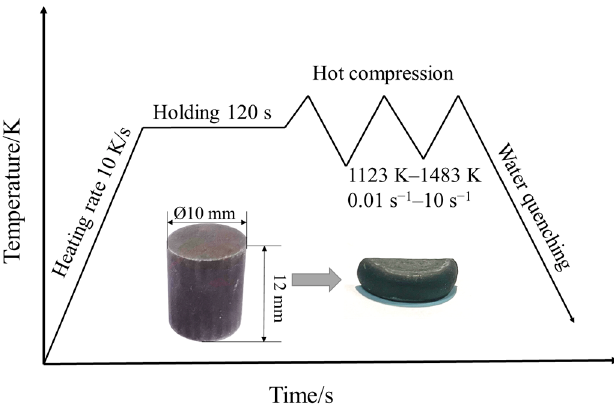
Figure 4. Isothermal compression deformation process.